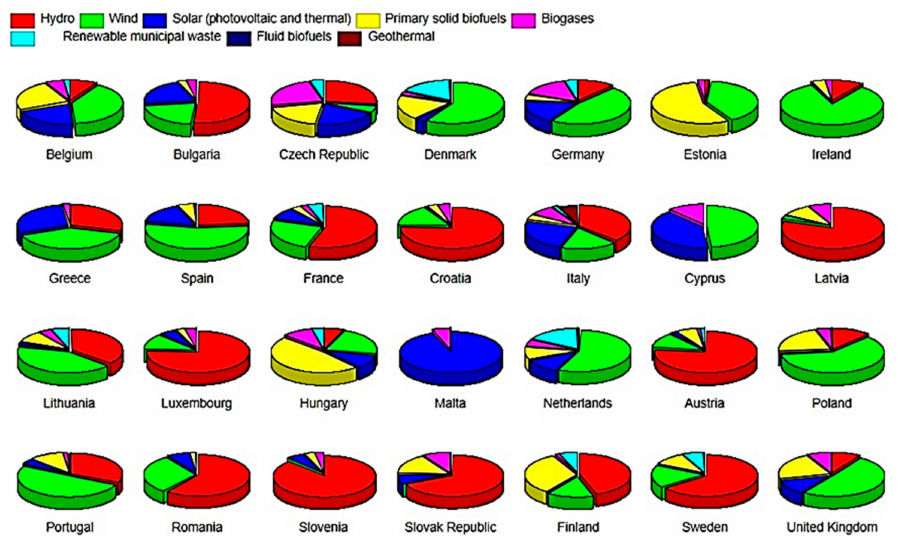
Figure 5. Structure of energy produced from renewable energy sources in the EU countries in 2017 (own study based on data from